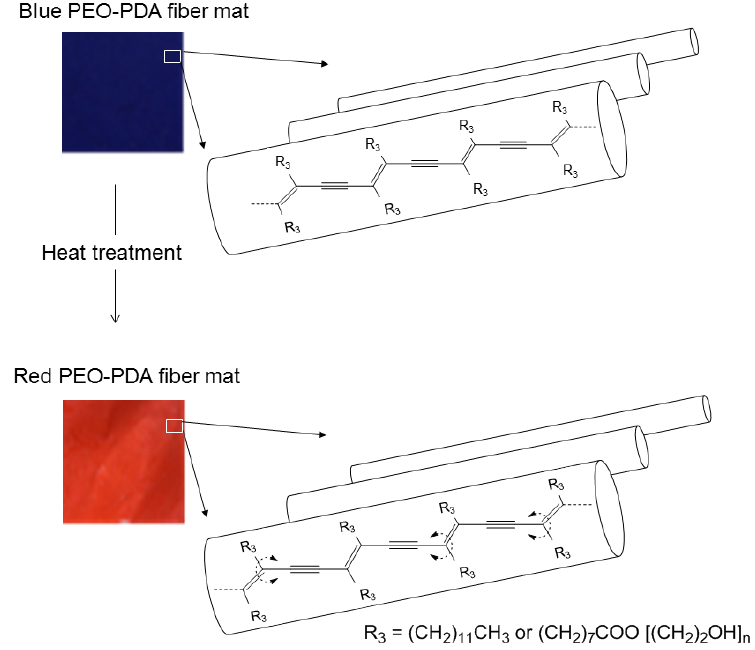
Figure 8. An illustration of color transition from blue to red in PEO-PDA fiber mat, which is due to a C-C bond rotation induced by heat treatment.